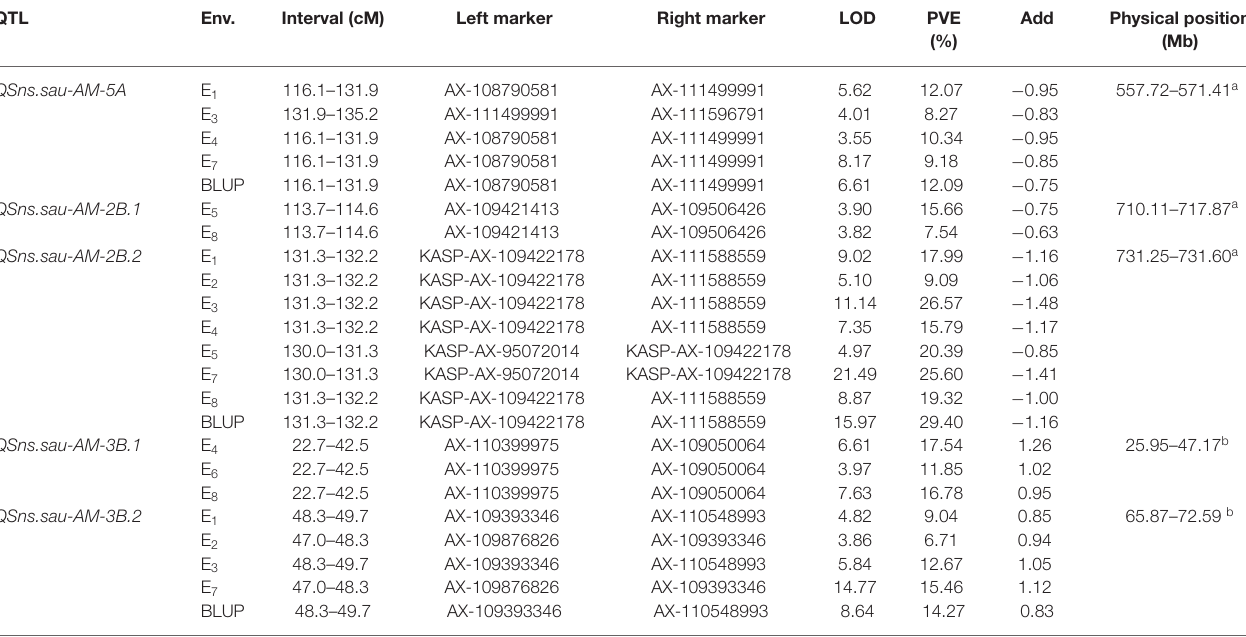
TABLE 4 | Quantitative trait loci (QTLs) for SNS identified in multiple environments in the AM